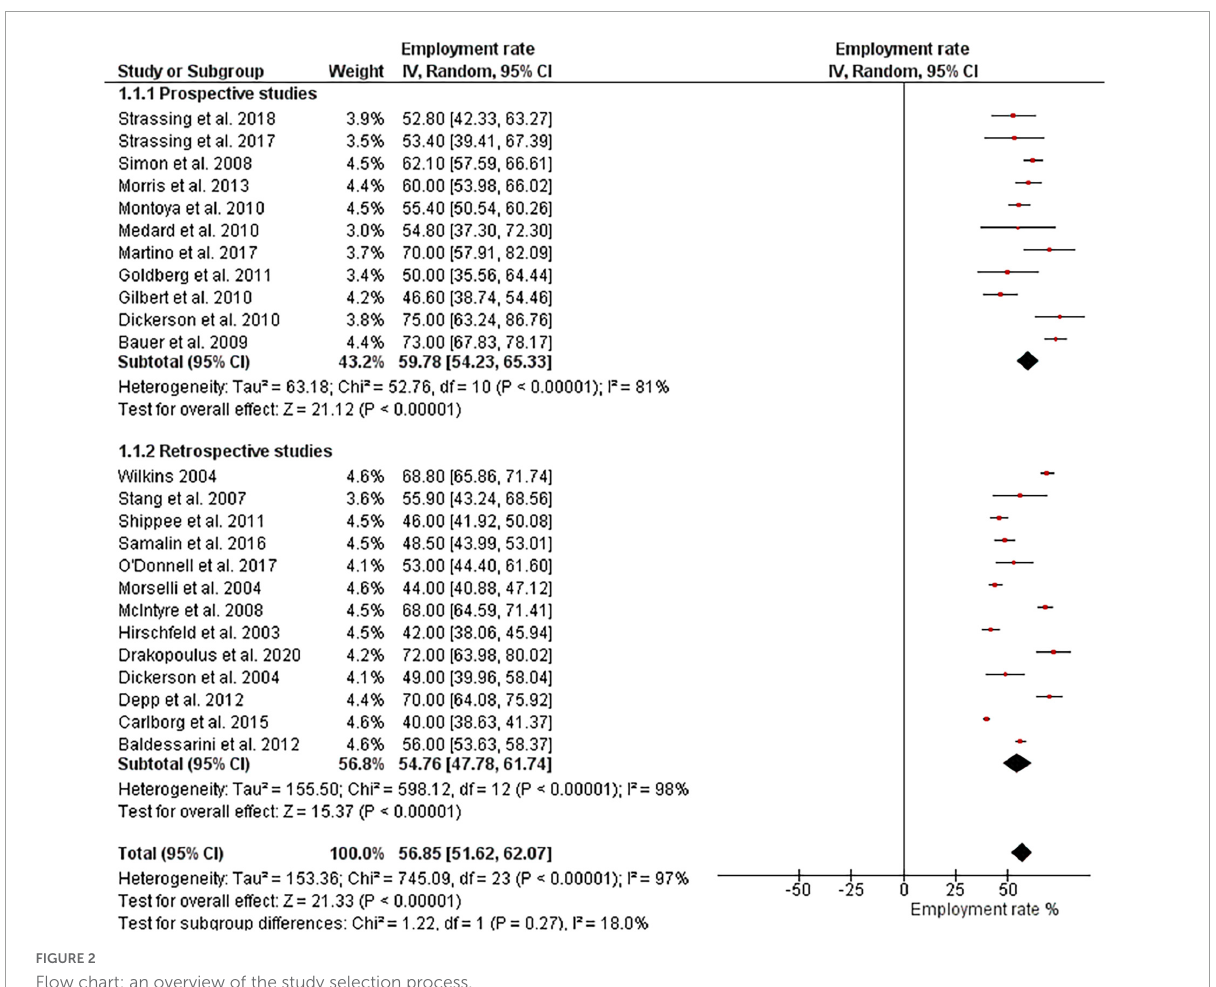
FIGURE2 Flow chart: an overview of the study selection